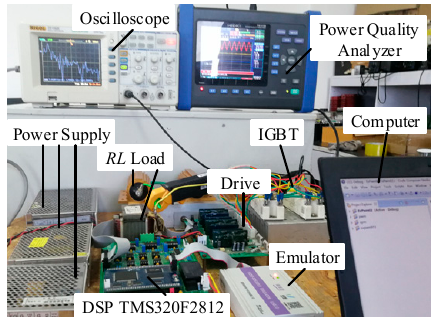
Figure 5. Experimental system. Table 1. System parameters.